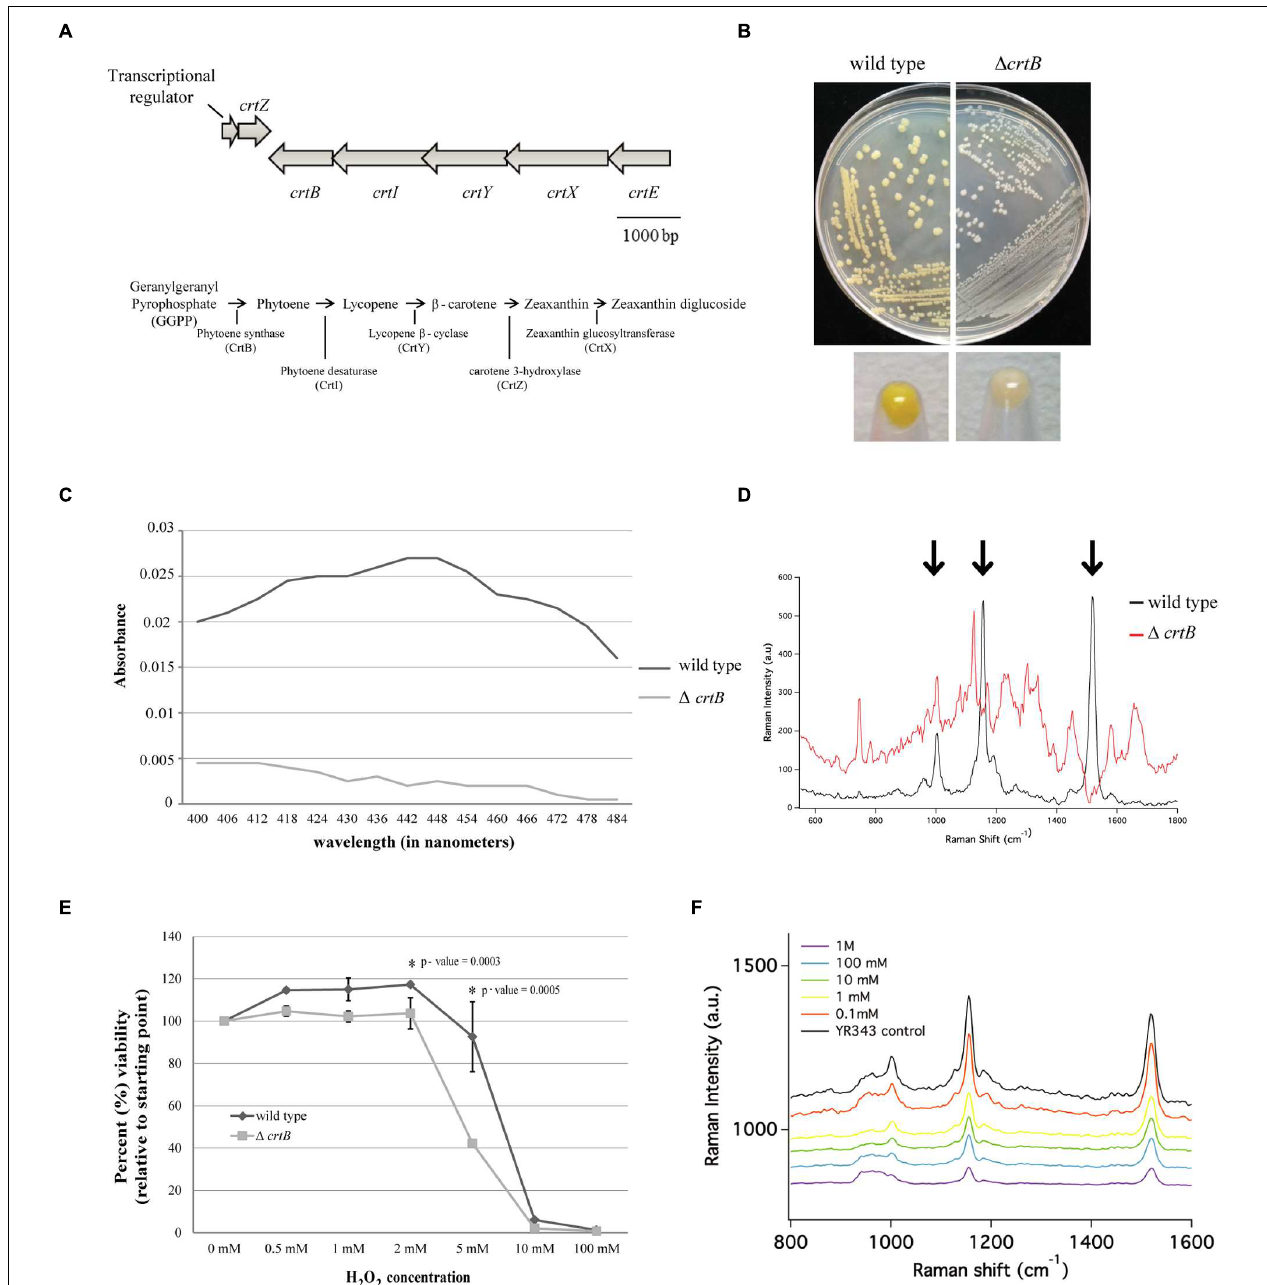
FIGURE 4 | Identification and characterization of a carotenoid mutant in Pantoea sp. YR343. (A) Top, genomic structure of operon regulating carotenoid production. Bottom, predicted carotenoid biosynthesis pathway in Pantoea sp. YR343 based on genomic comparisons. PMI39_03412 encodes a product with 60% amino acid identity and 74% amino acid similarity to P. ananatis CrtE; PMI39_03408 encodes a product with 66% amino acid identity and 76% amino acid similarity to P. ananatis CrtB; PMI39_03409 encodes a product with 81% amino acid identity and 87% amino acid similarity to P. ananatis CrtI; PMI39_03410 encodes a product with 58% amino acid identity and 74% amino acid similarity to P. ananatis CrtY; PMI39_0340 encodes a product with 84% amino acid identity and 92% amino acid similarity to P. ananatis CrtZ, and PMI39_03411 encodes a product with 53% amino acid identity and 61% amino acid similarity to P. ananatis CrtX. (B) LB plates streaked with wild type Pantoea sp. YR343 (left) and (cid:49) crtB (right) and grown for 48 h showing loss of pigmentation in the mutant strain. (C) Methanol extraction of carotenoids from wild type Pantoea sp. YR343 and (cid:49) crtB . Graph represents the range of absorbances between 400 and 500 nm measured from one of two replicates. (D) Raman spectroscopy of wild type Pantoea sp. YR343 and (cid:49) crtB . The wild type strain shows a spectra dominated by peaks (highlighted by arrows) corresponding to zeaxanthin. These peaks are reduced in the (cid:49) crtB mutant. (E) Sensitivity of wild type and (cid:49) crtB mutant cells to increasing concentrations of hydrogen peroxide. Cell viability was measured using the Bac-Titer Glo assay and plotted as a percentage relative to the untreated control, measured as 100%. (F) Raman spectroscopy of wild type Pantoea sp. YR343 treated with different concentrations of hydrogen peroxide shows a decrease in peak intensity at 1500 cm − 1 upon treatment with hydrogen